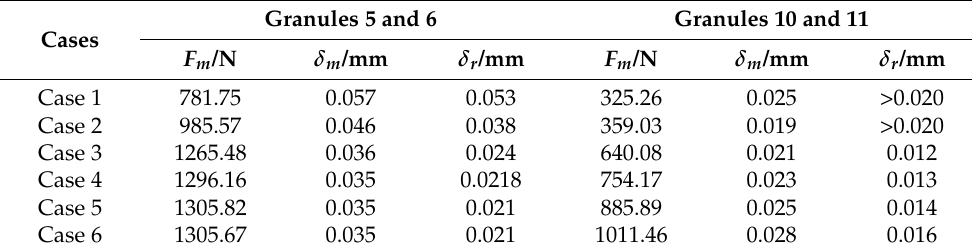
Table 5. Variations of F m , δ m , and δ r for all